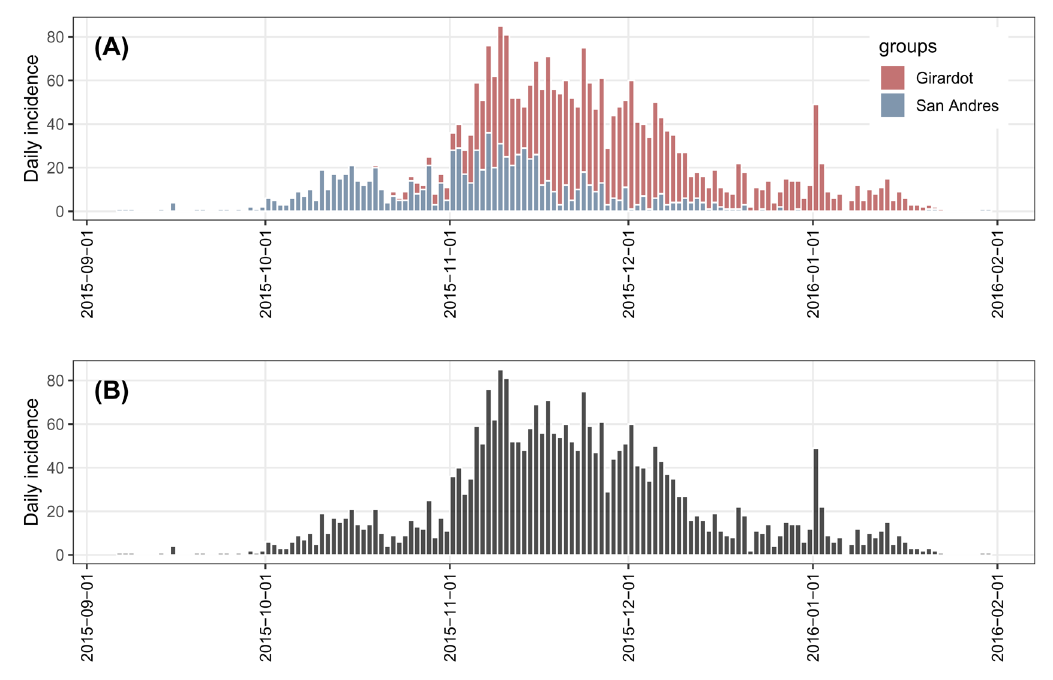
Figure 4. ( A ) stratified and ( B ) pooled daily incidence plots of ZVD in Colombia, September 2015 to January